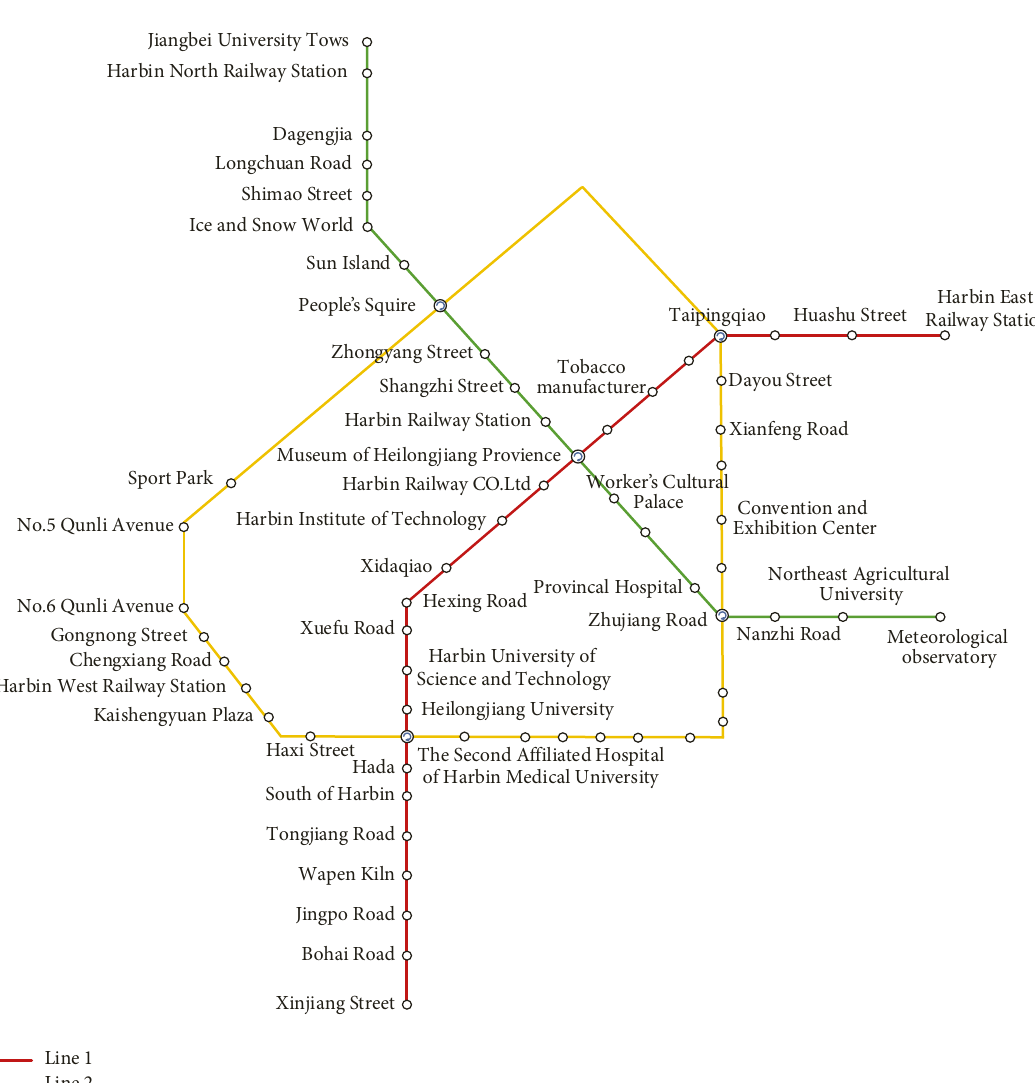
Figure 3: Map of the harbin metro